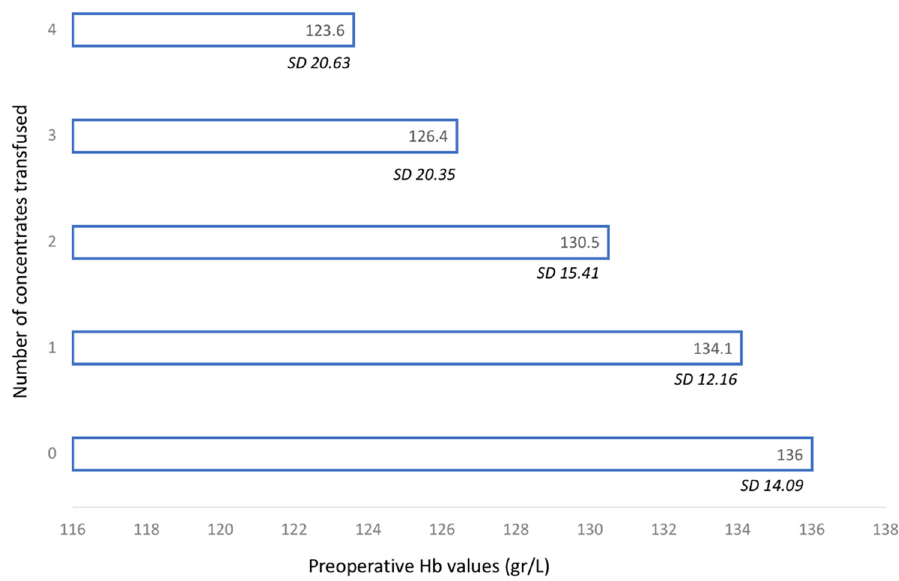
Figure 2. Preoperative hemoglobin values (g/L) in relation to the number of transfused blood concentrates (0–4).